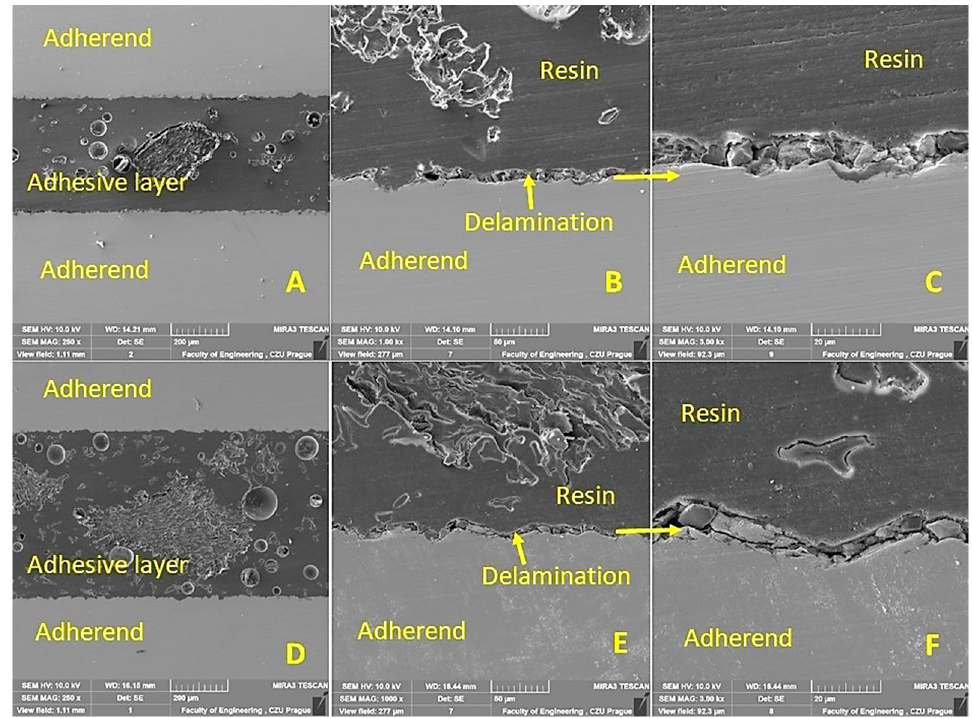
Figure 14. SEM analysis of a cross section of a hybrid J-filler adhesive layer after 1000 cycles at a load cycle test of 5–50% (Oxford SE detector): ( A ): Cross-section of hybrid adhesive bond with J-based filler (MAG 250×), ( B ): Interaction between adherend and hybrid adhesive layer (MAG 1000×), ( C ): Detail of the interaction between the hybrid adhesive layer and the adherend (MAG 3000×), ( D ): Cross-section of hybrid adhesive bond with filler J_NaOH (MAG 250×), ( E ): Interaction between adherend and hybrid adhesive layer (filler J_NaOH and resin) (MAG 1000×), ( F ): Detail of the interaction between the hybrid adhesive layer and adherend (MAG 3000×).